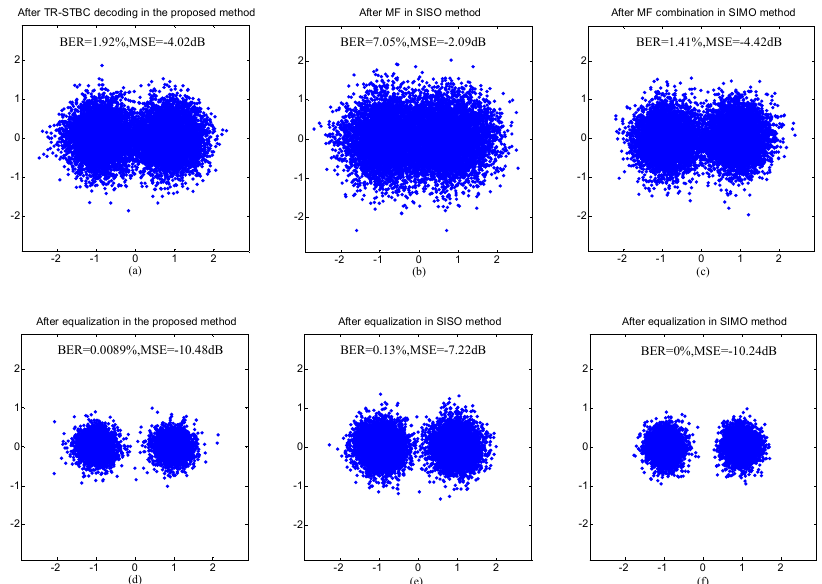
Figure12. Comparisonoftotalperformanceamongthethreecommunicationmethodsintheexperiment: ( a ) and ( d ) after TR-STBC decoding and adaptive equalization in the proposed method; ( b ) and ( e ) after MF and adaptive equalization in the SISO method; ( c ) and ( f ) after MF combination and adaptive equalization in the SIMO